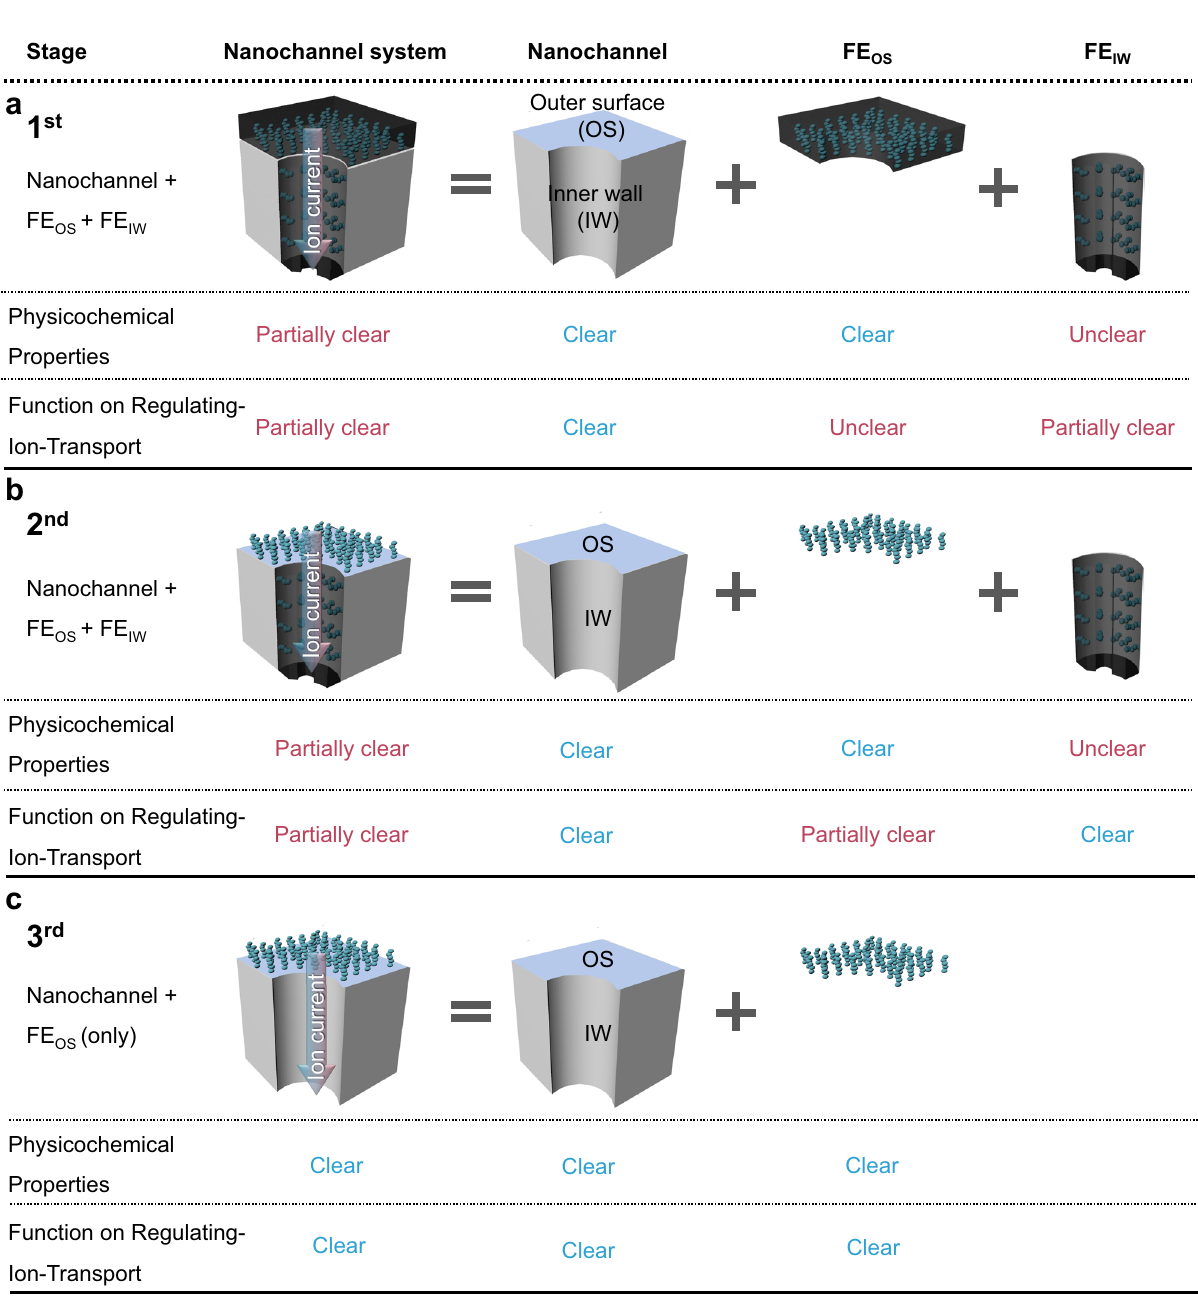
on regulating-ion-transports and the other is Two black shades refer to the two “black boxes” : one is the role of FE OS unclear physicochemical properties of FE . IW Fig. 1 Designed nanochannel-systems attached with FE OS and FE IW . a Stage 1, FE OS and FE IW immobilized as a whole, in which the role of FE OS on ion transport and the properties of FE IW are inexplicit (two “ black boxes ” exist). b Stage 2, FE OS and FE IW as distinct part, in which the role of FE OS on ion transport began to be paid attention and investigated, but the properties of FE IW are still inexplicit (start to open the 1st “ black box ” ). c Stage 3, in this work, independent FE OS without FE IW in nanochannel-system for regulating-ion-transport (further reveal the 1st “ black box ” ), in which the properties of both FE OS and nanochannels are measurable, making the properties of the whole nanochannel-system explicit to a great extent (avoid the trouble from the 2nd “ black box ” used in equation were unmeasurable, as (1) the depth of FE at IW, (2) the surface charge, and (3) the diameter of the nanochannels after attaching FE IW . Hence, the hypotheses of the above three parameters were generated in the 1st and 2nd stage, which is unavoidable: (1) FE may not completely cover IW, but leaving the blank area of the deep IW hard for FE to reach 34 .